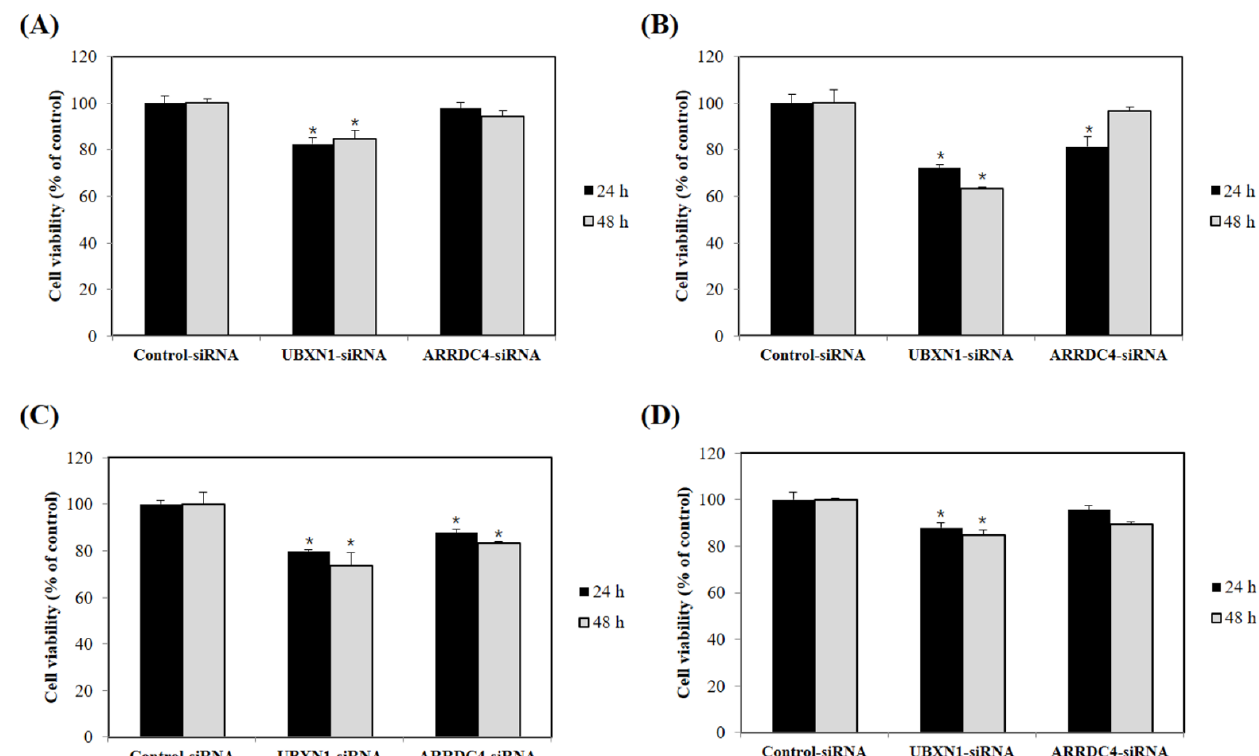
Figure 3. Knockdown of UBXN1 and ARRDC4 inhibits prostate cancer cell growth. PC3 ( A ), DU145 ( B ), LNCaP ( C ), and 22Rv1 cells ( D ) were transfected with siRNA targeted UBXN1 and ARRDC4 or its negative control. Cell viability was measured by CCK-8 assay. Data are the average of at least three independent experiments. * p < 0.05 compared to negative control.